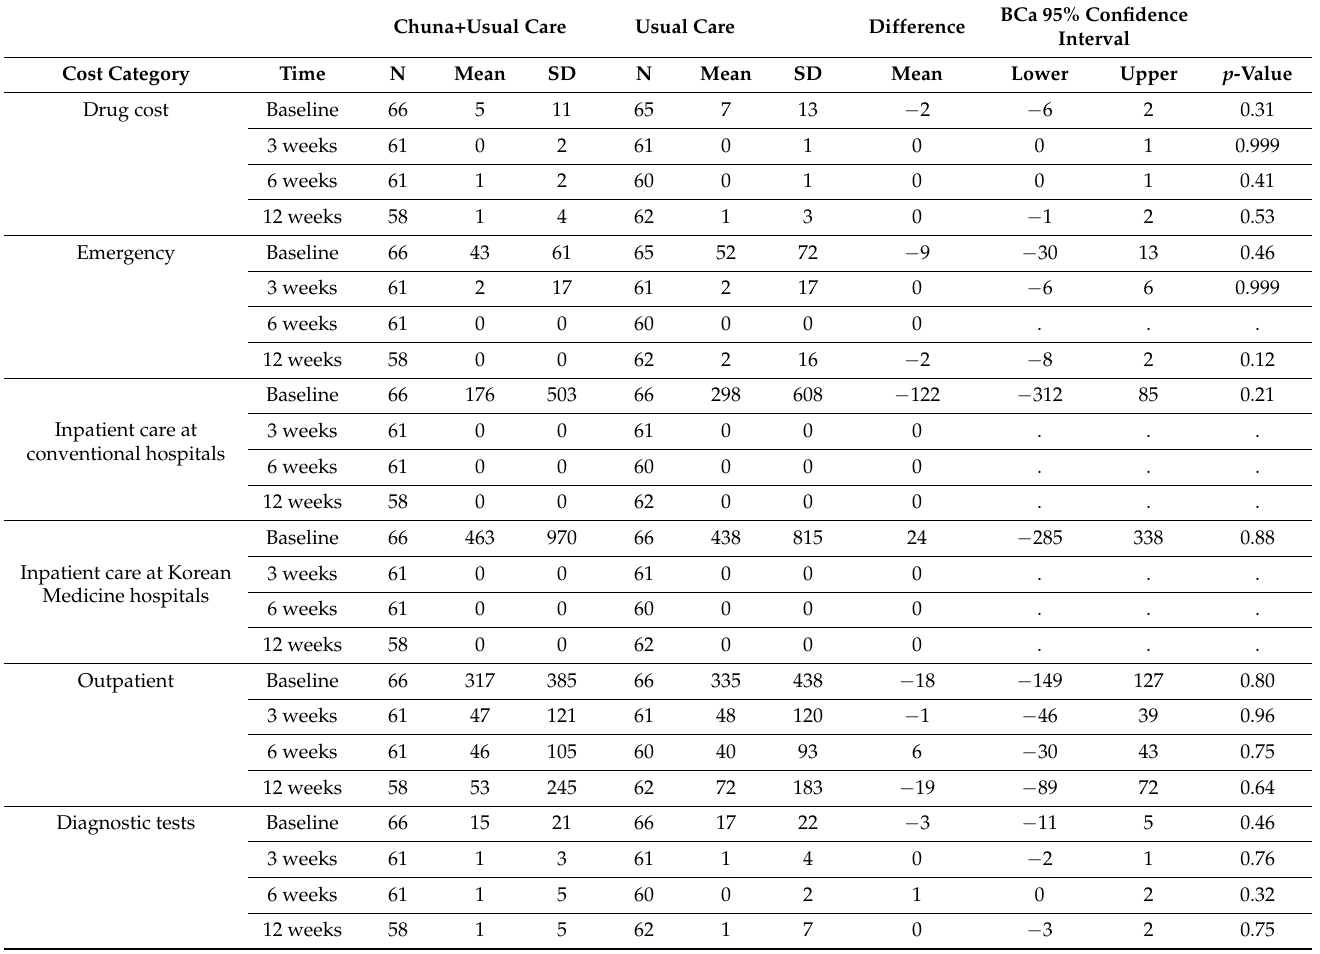
Table 1. Health care costs at four